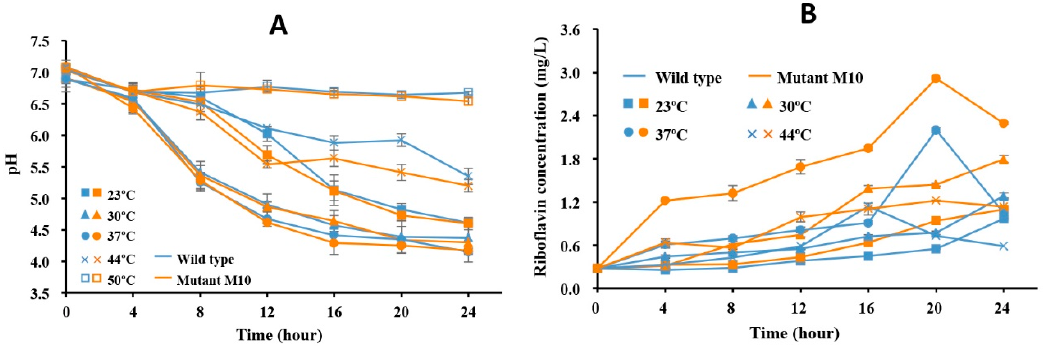
Figure 5. ( A ) pH value of fermented soymilk by the RYG-YYG-9049 wild strain and its No. 10 mutant strain under di ff erent conditions. ( B ) Changes of riboflavin value in soymilk that was inoculated with the bacteria at di ff erent time and